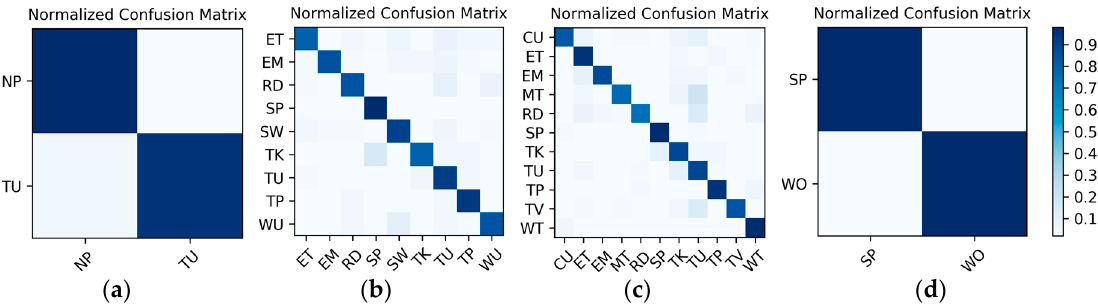
Figure 13. W1’s confusion matrices for the output of the VGG conv corresponding to each group: ( a ) lying; ( b ) sedentary; ( c ) standing; ( d ) walking.